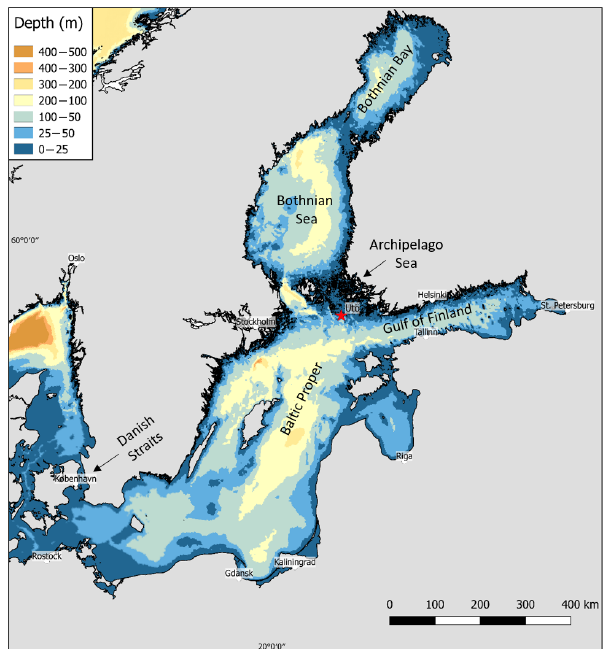
Figure 1. Map of the Baltic Sea. The Utö measurement site is in- dicated with a red star. The local bathymetry around Utö Island is shown in Fig. A1 in Appendix